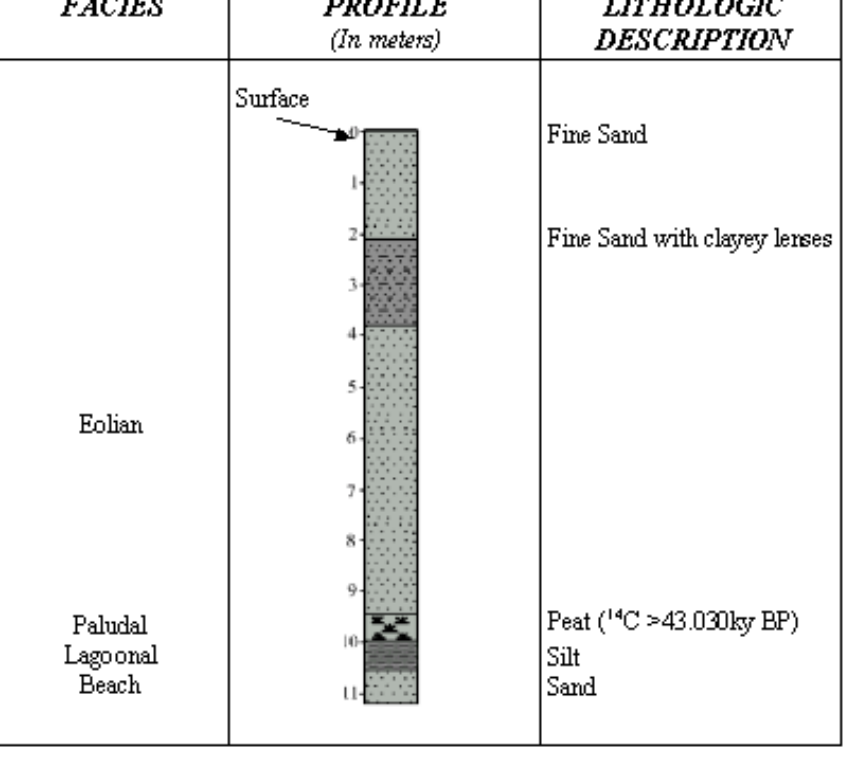
Fig. 4 – Drilling profile at north of Mirim Lagoon (28 ◦ 12’33”S/40 ◦ 43’05”W), near Nova Brasília town (See geological map – Drilling